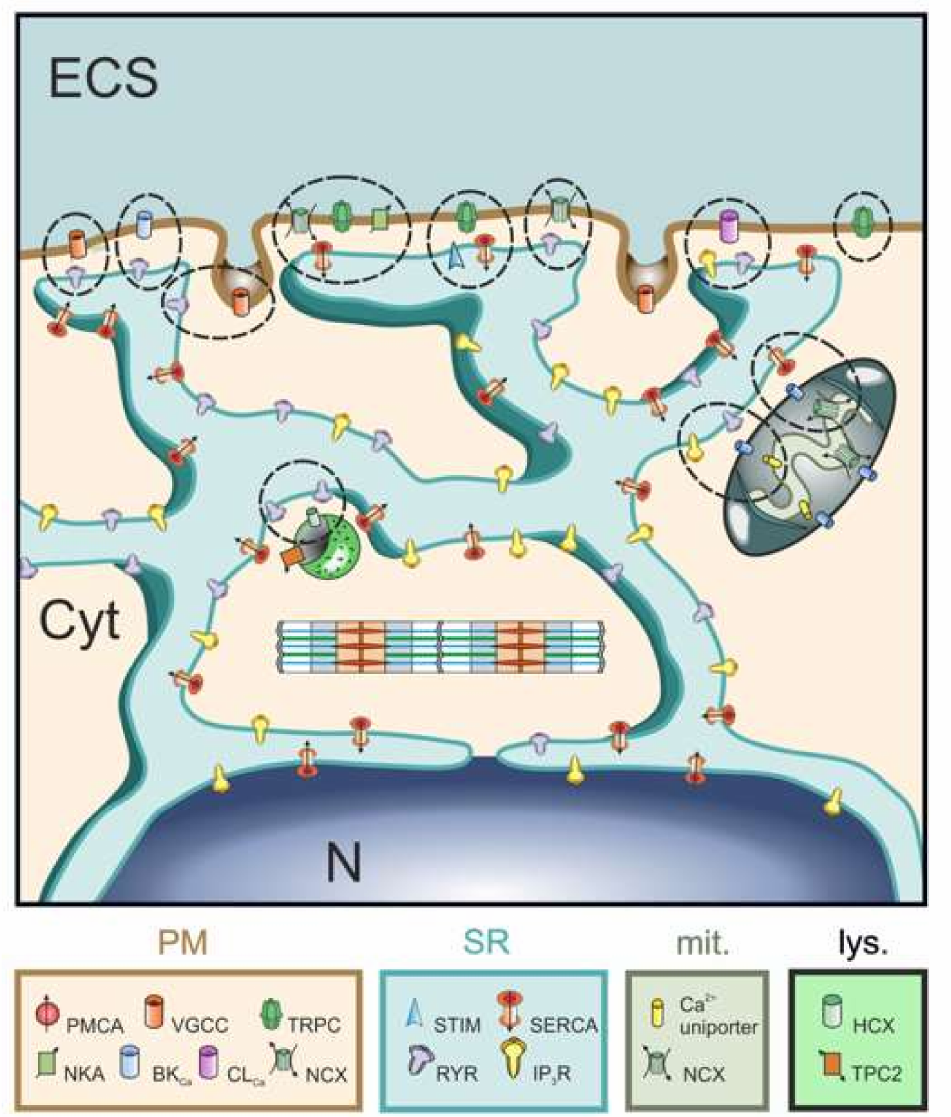
Figure 1. Hypothetical rendition of how the ER coordinates a multitude of different Ca 2+ signals by involving multiple NJs between the ER membrane, on the one hand, and the PM, mitochondria and lysosomes, on the other. Each possible signaling process within NJs is indicated by dashed ellipses (based on Figure 1 in [3]). The ion transporter content of each junction (codes shown below the picture) is based on experimental evidence in the literature, which varies from solid to hypothetical. The descriptive boxes below the drawing are color-coded to their respective organelles/NJs in the drawing. ECS: extra-cellular space; cyt: cytoplasm; lys.: lysosome; mit.: